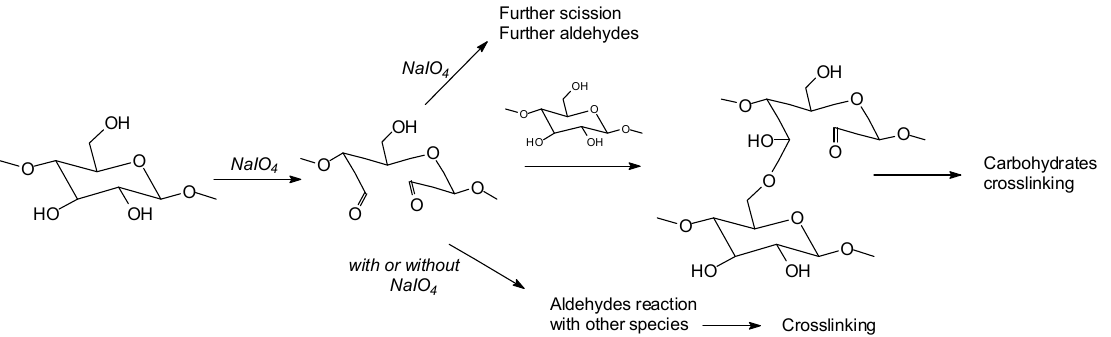
Figure 2. Specific oxidation of carbohydrates by sodium periodate leading to nontoxic and nonvolatile biosourced aldehydes and to different crosslinked products according to the conditions used [54].